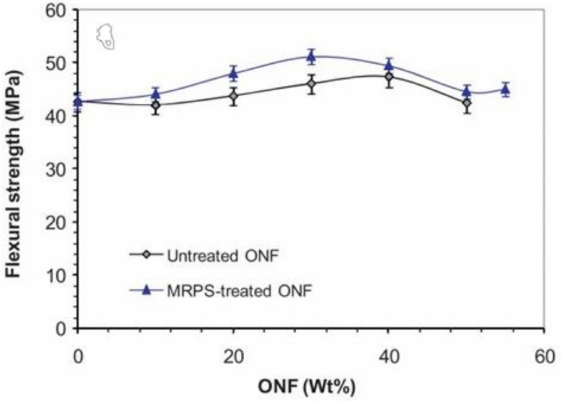
Figure 10. Evolution of the flexural strength versus ONF content [61].